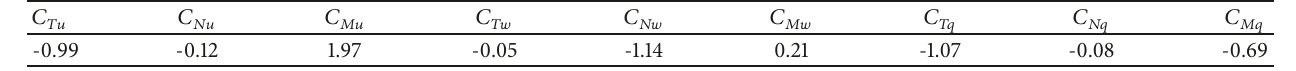
Table 1: Nondimensionalized aerodynamic derivatives of FMAV near hovering.